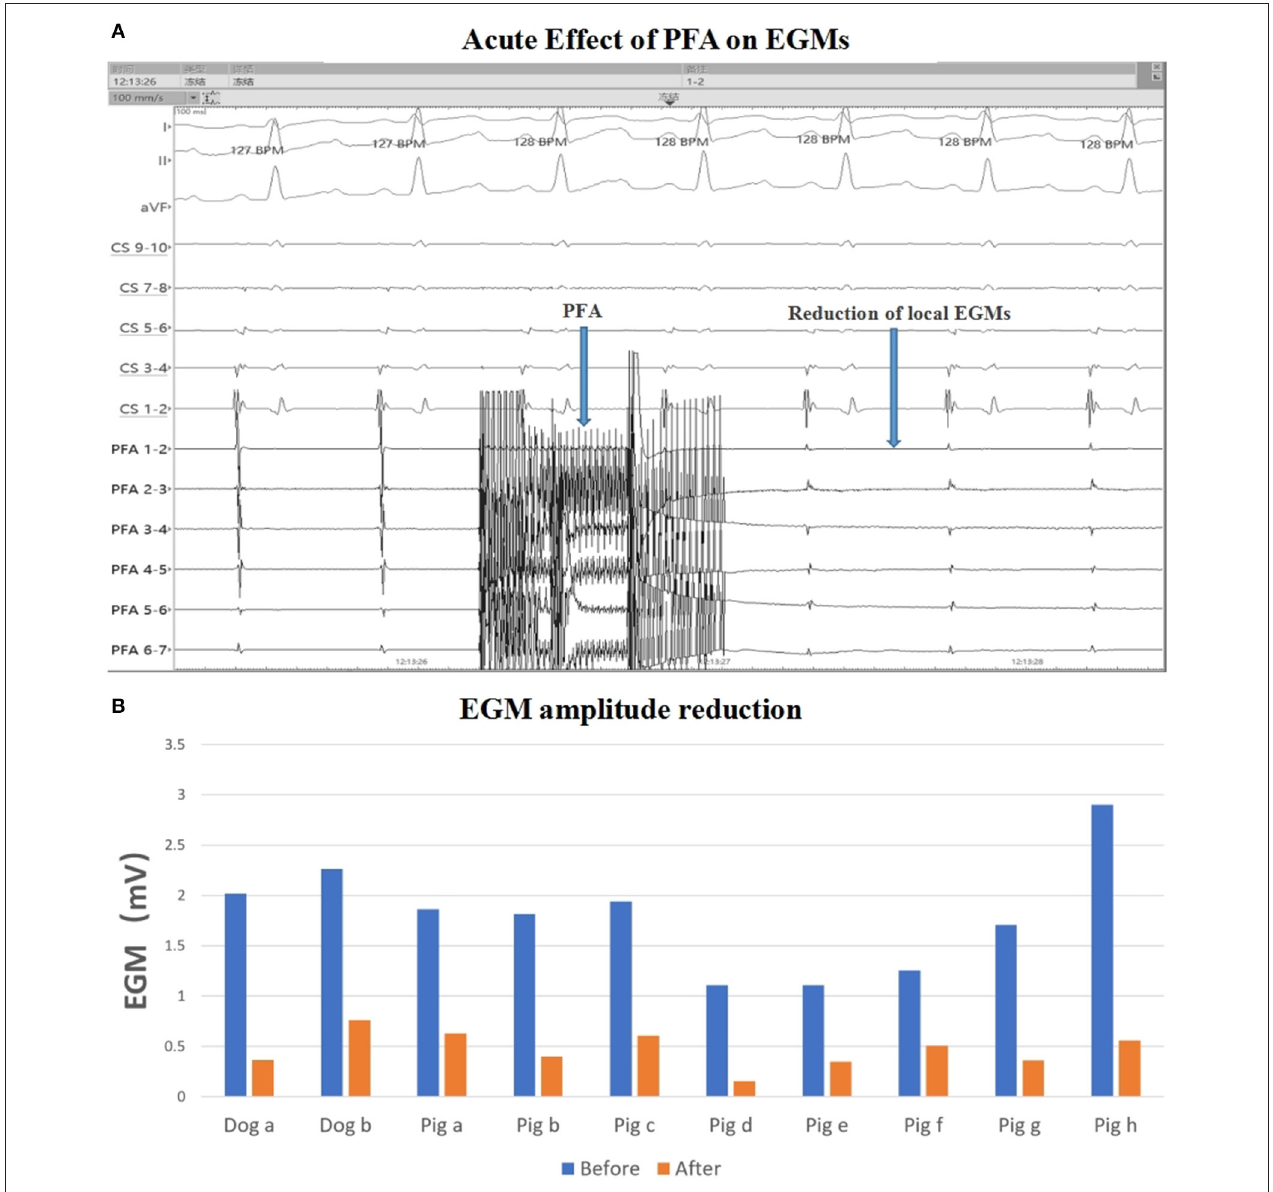
FIGURE 2 | EGM amplitude change. (A) EGM signal reduction with PFA; (B) EGM amplitude before and after ablation in each animal. The mean EGM amplitude were reduced after ablation. PFA, Pulsed field ablation.